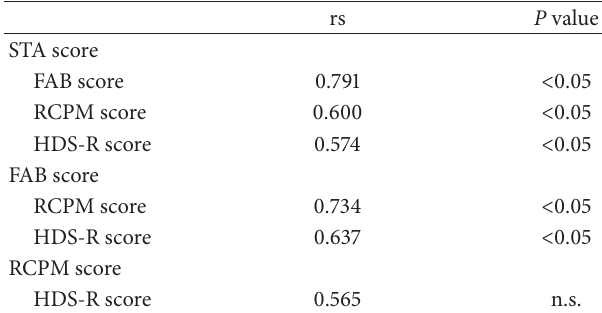
Table 5: Spearman rank correlation coefficient among neuropsy- chological